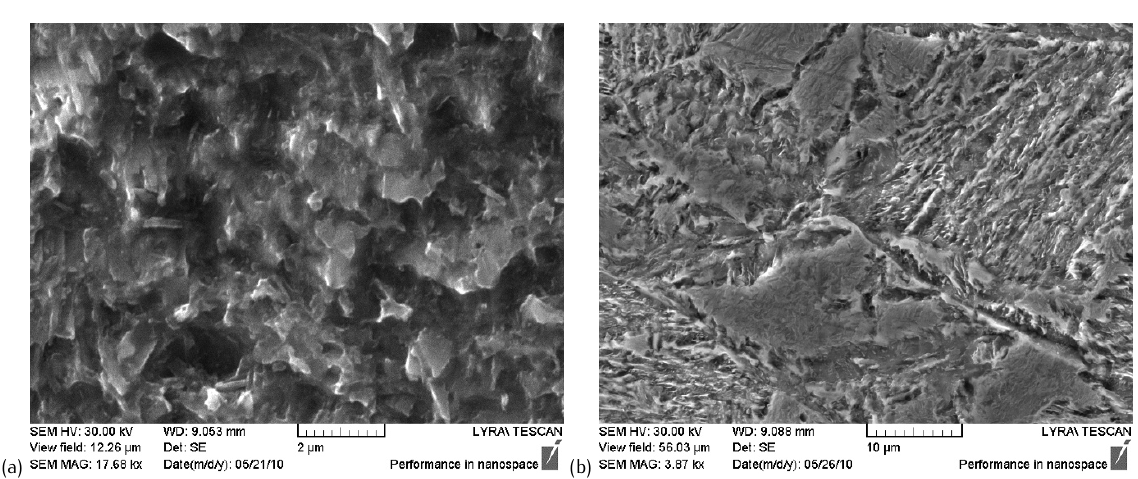
Figure 5. Microstructure at the largest magnification: (a) granular bainite, (b) acicular bainite.